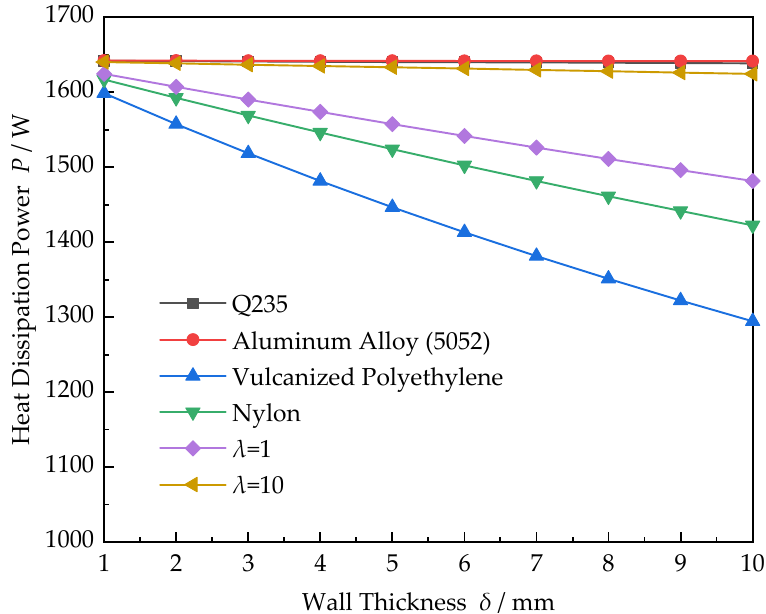
Figure 8. Curve of heat dissipation power of tank with wall thickness.